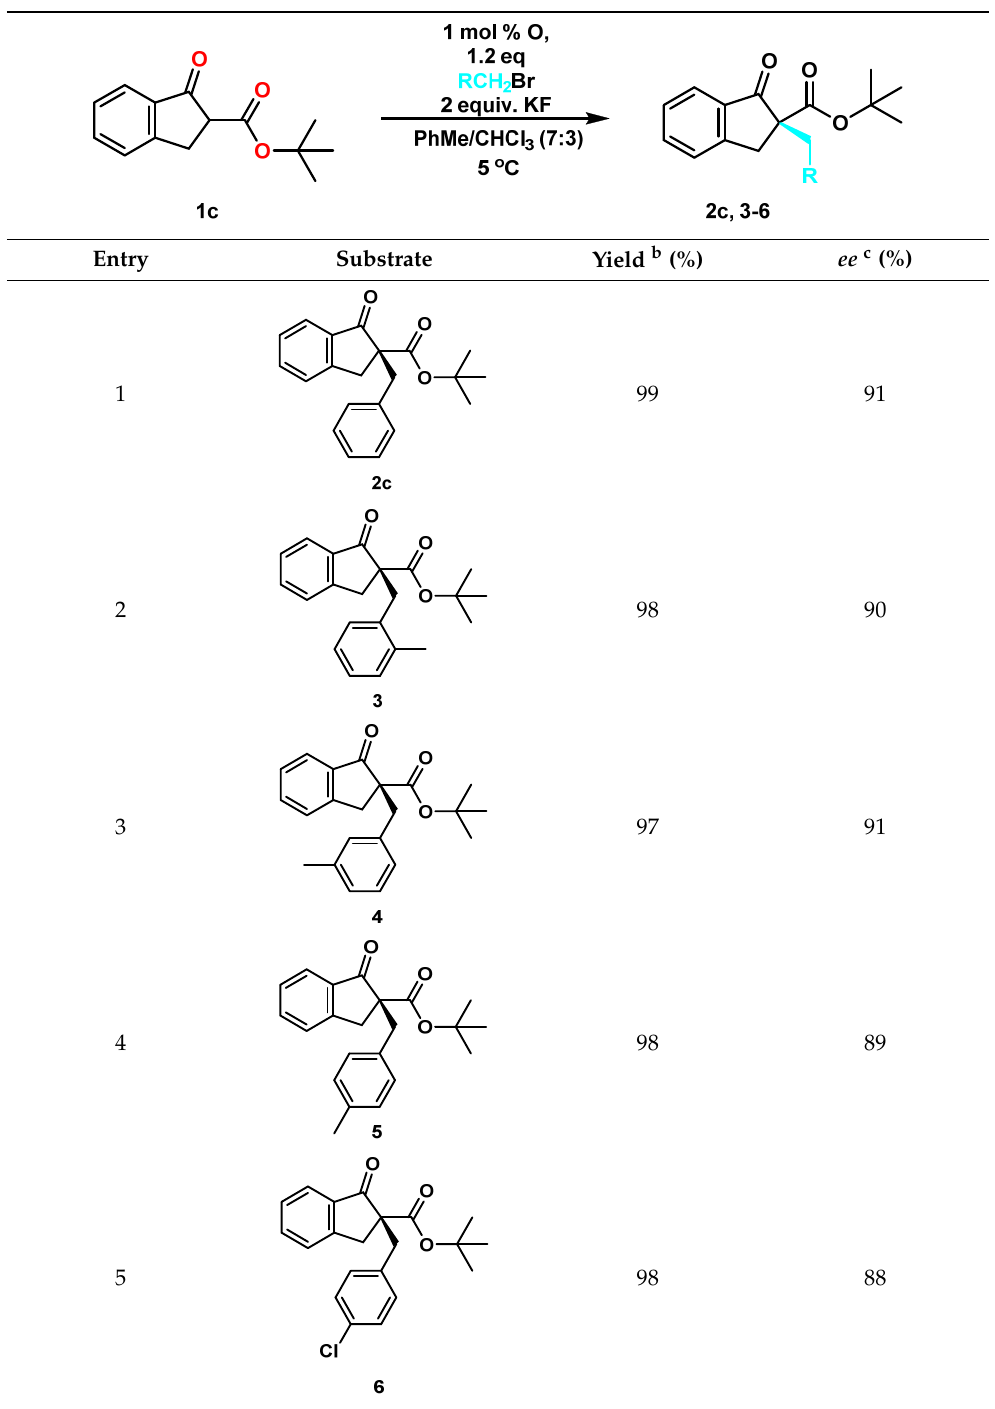
Table 4. Screening of alkylating agents a .